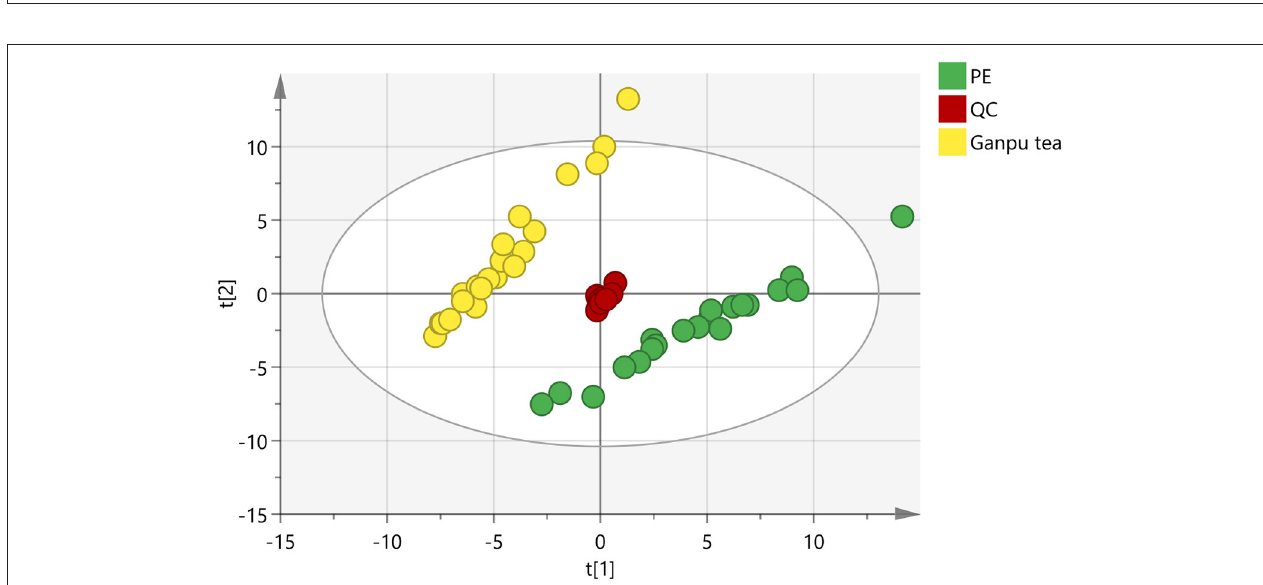
FIGURE 4 | Score plot of principle component analysis of 2017 features ( R 2 X = 0.834, Q 2 = 0.741). Green circles represent Pu-erh tea (PE) samples, yellow circles represent Ganpu tea (Pu-erh tea that cofermented with Citrus peel) samples, and red circles represent quality control (QC) samples.